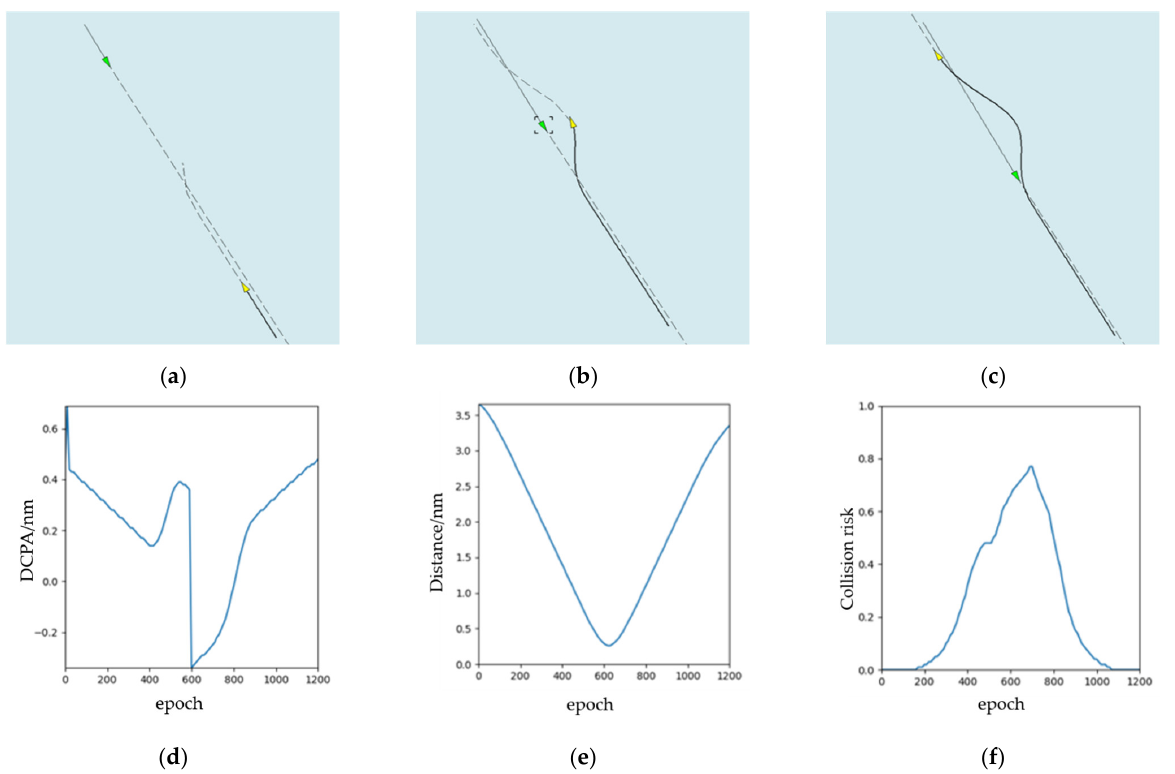
Figure 9. The experimental results (head-on): ( a ) the start time during the collision avoidance process; ( b ) the middle time during the collision avoidance process; ( c ) the end time during the collision avoidance process; ( d ) DCPA; ( e ) distance; ( f ) collision risk.